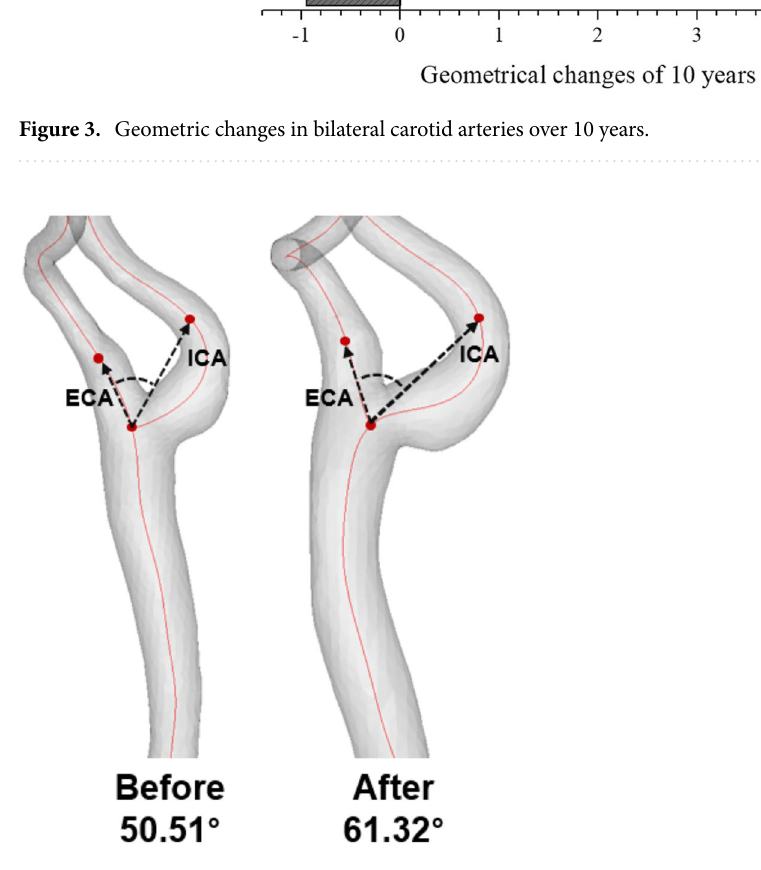
Figure 4. The representative case (left side) of geometric changes over 10